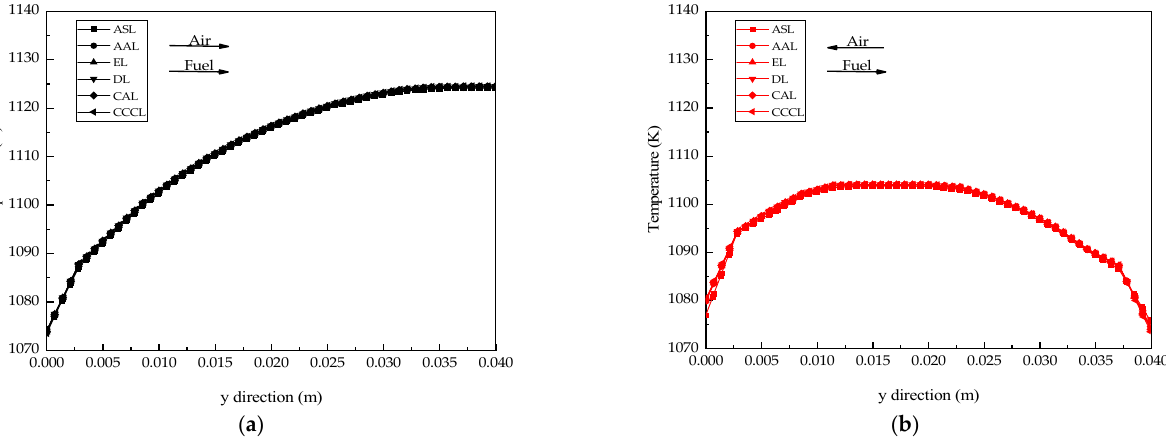
Figure 11. Distribution of temperature of each component along the forward direction of y-axis for case C. ( a ) Co-flow; ( b ) Counter − flow.